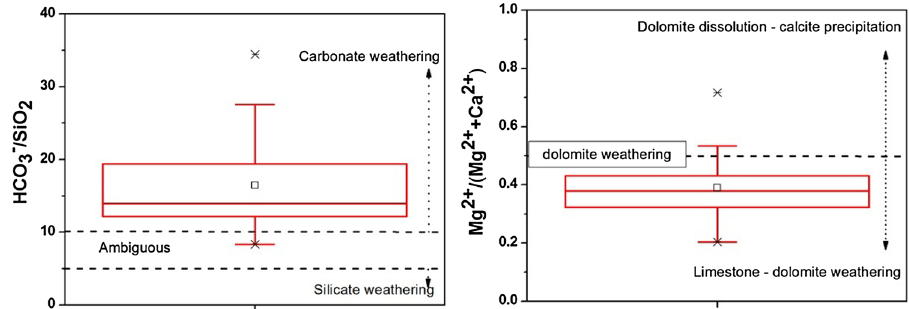
Fig. 8 Box-whisker plot of a HCO 3− /Si ratio and b Mg 2+ / (Mg 2+ + Ca 2+ ) ratio of water